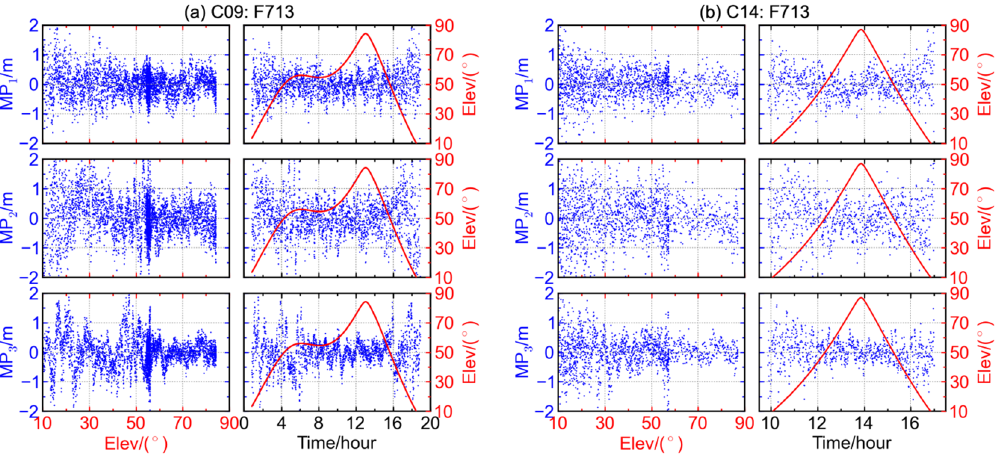
Figure 9. The multipath combinations of BDS satellites ( a ) C09 (IGSO) and ( b ) C14 (MEO); after the elevation-dependent correction model is applied.